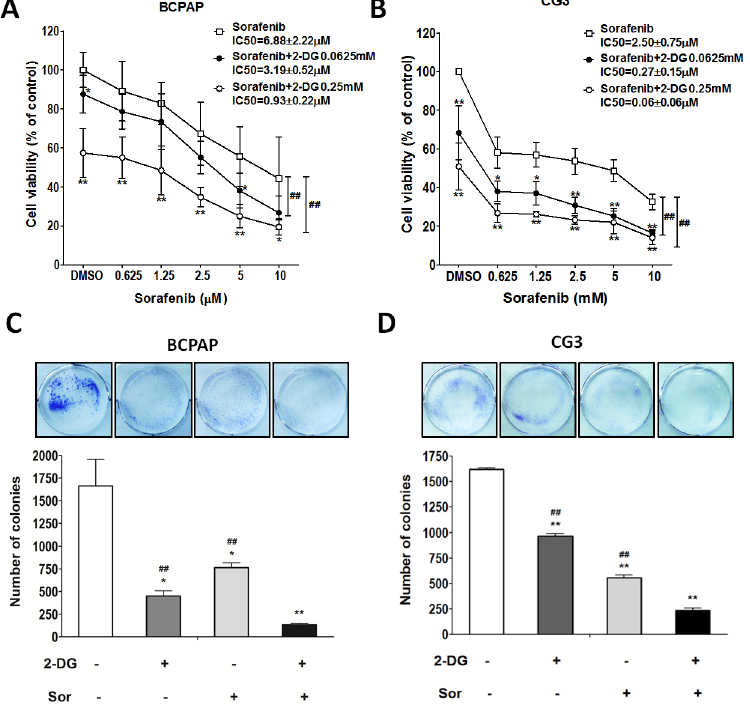
Fig 5. Effects of sorafenib on the viability of PTC cells treated or not with 2-DG. (A, B) BCPAP and CG3 cells cultured in medium supplemented with 10% fetal bovine serum were treated for 48 h with different concentrations of sorafenib in the presence or absence of 2-DG. Post-treatment, cell viability was measured using a WST-1 assay. (C, D) Colony formation in BCPAP and CG3 cells treated for 48 h with 0.25 mM 2-DG, 2.5 μ M sorafenib, or both. The medium was replaced with fresh medium for 3 – 5 days to check for colony formation. * p < 0.05, ** p < 0.001, compared to the controls ( t test); A, B: ## p < 0.001, 2-way ANOVA; C, D: ## p < 0.001, compared to 2-DG plus sorafenib treatment ( t test). Data are presented as means ± standard deviation